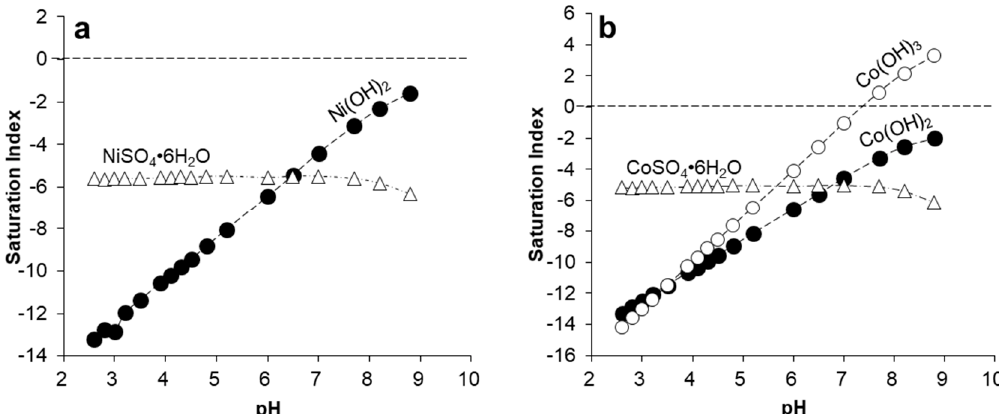
Figure 9. Evolution of the saturation index (SI) for selected Ni ( a ) and Co ( b ) mineral phases with pH during neutralization of acidic mine water. Calculations conducted with PHREEQCI using the MinteqA2.v4 thermodynamic database (same conditions as in Figure 8).